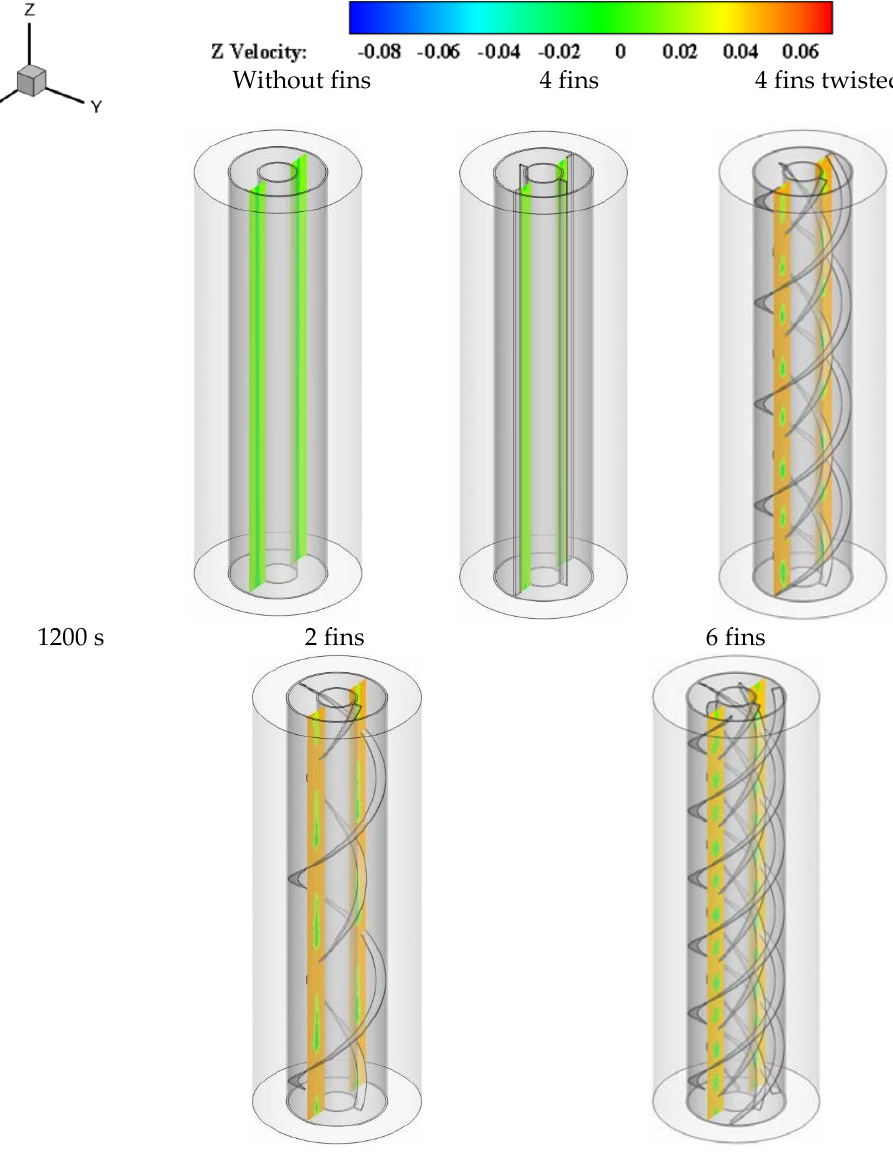
Figure 8. Evolution of z-velocity field for different studied cases at the time of 1200 s.